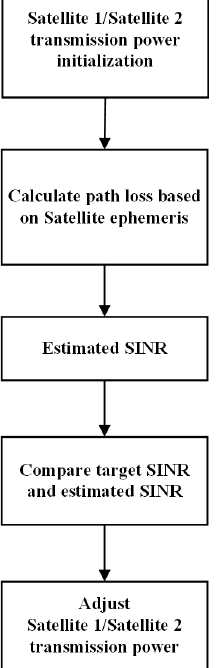
Figure 4. Diagram of open-loop power